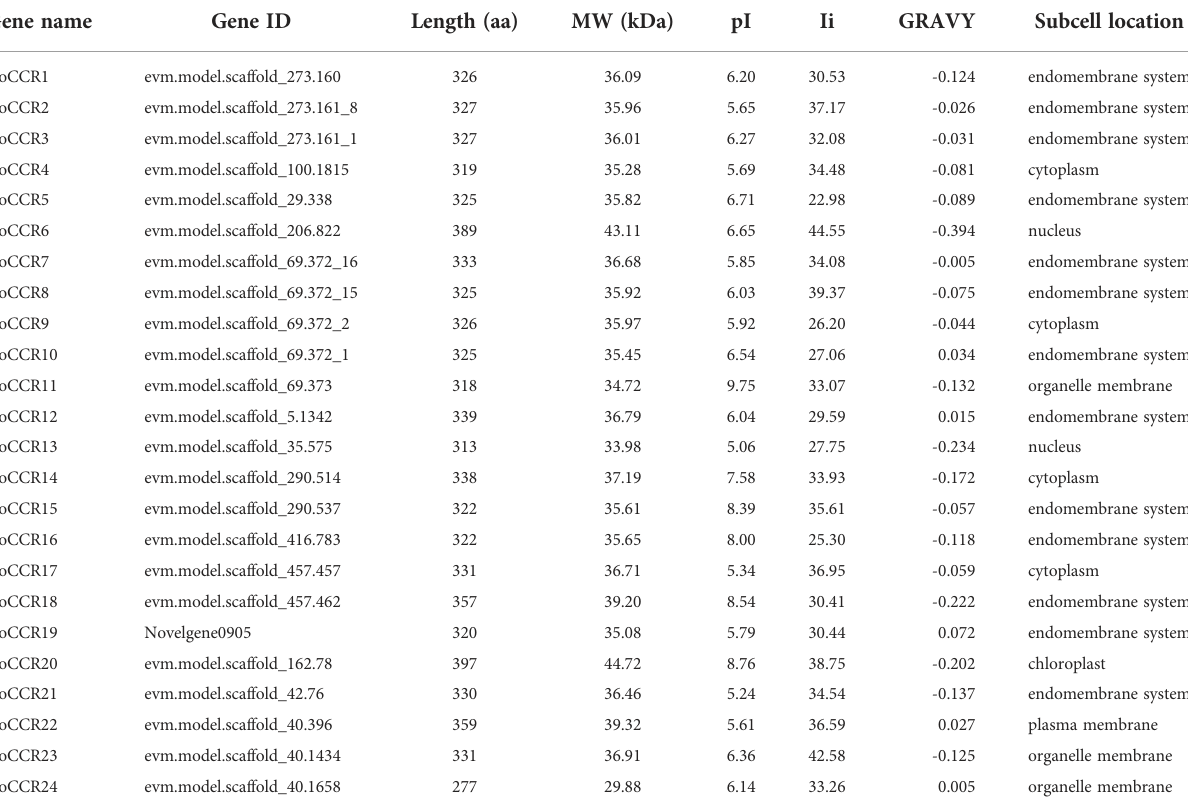
TABLE 1 Physicochemical properties and subcellular predictions of CCR gene family in D. odorifera